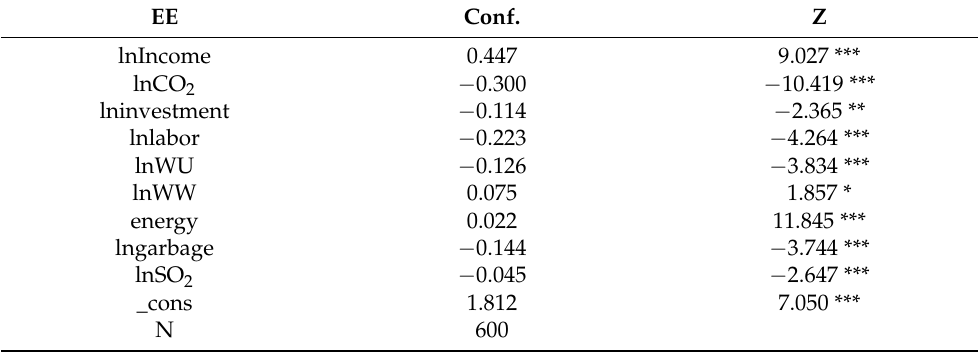
Table 4. Tobit regression results for internal driving forces controlling regional tourist-hotel eco-efficiency. EE